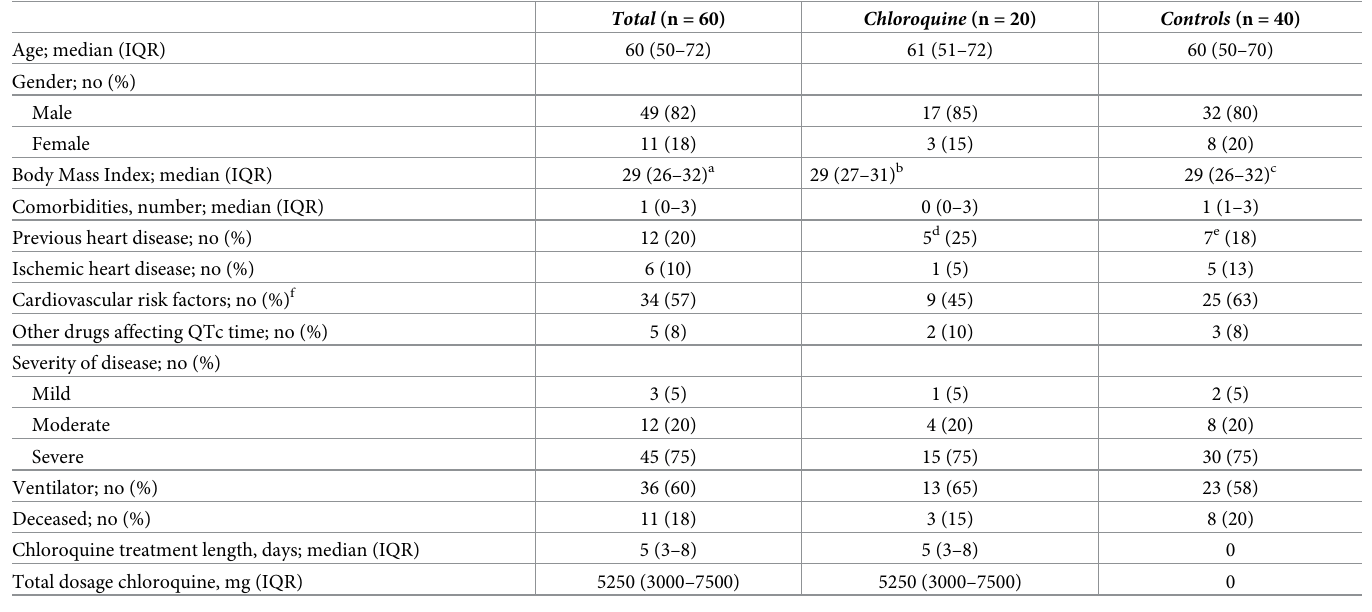
Table 1. Demographic characteristics of 60 study